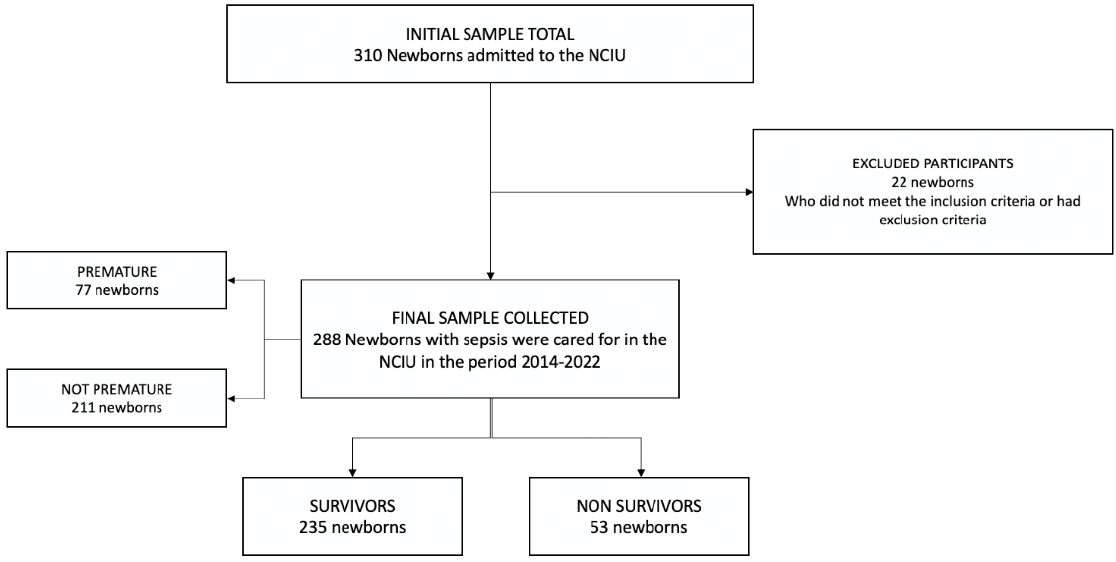
Figure 1. Sample selection flowchart.